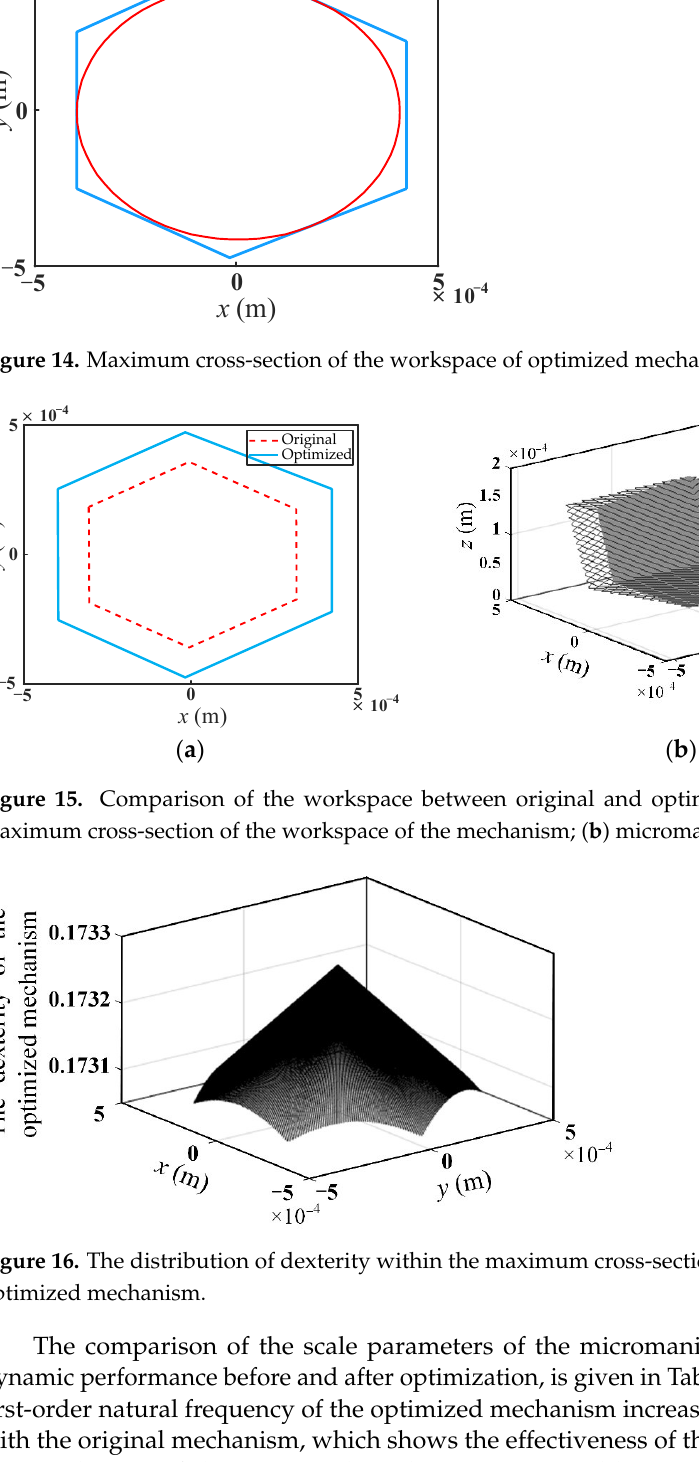
Figure 16. The distribution of dexterity within the maximum cross-section of the workspace of the optimized mechanism.